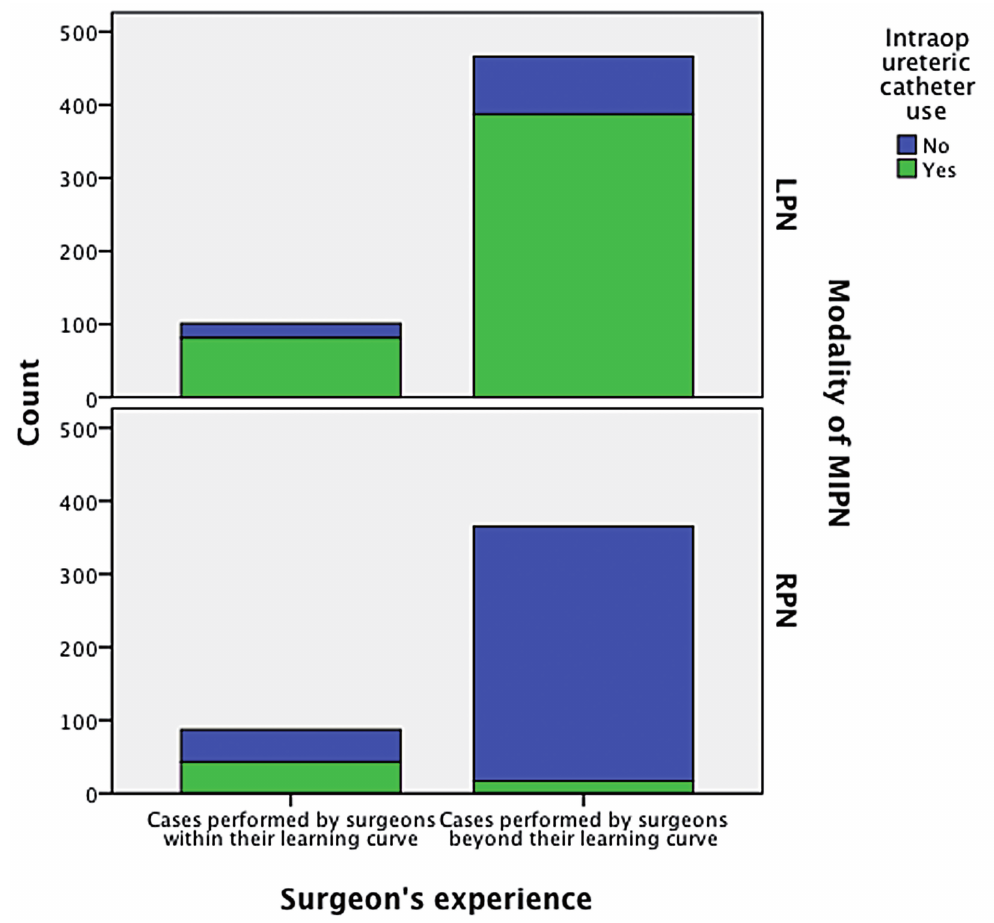
Figure 2 - Bar graphs demonstrating the rate of employment of intraoperative ureteric catheter according to surgeon’s experience for both LPN and